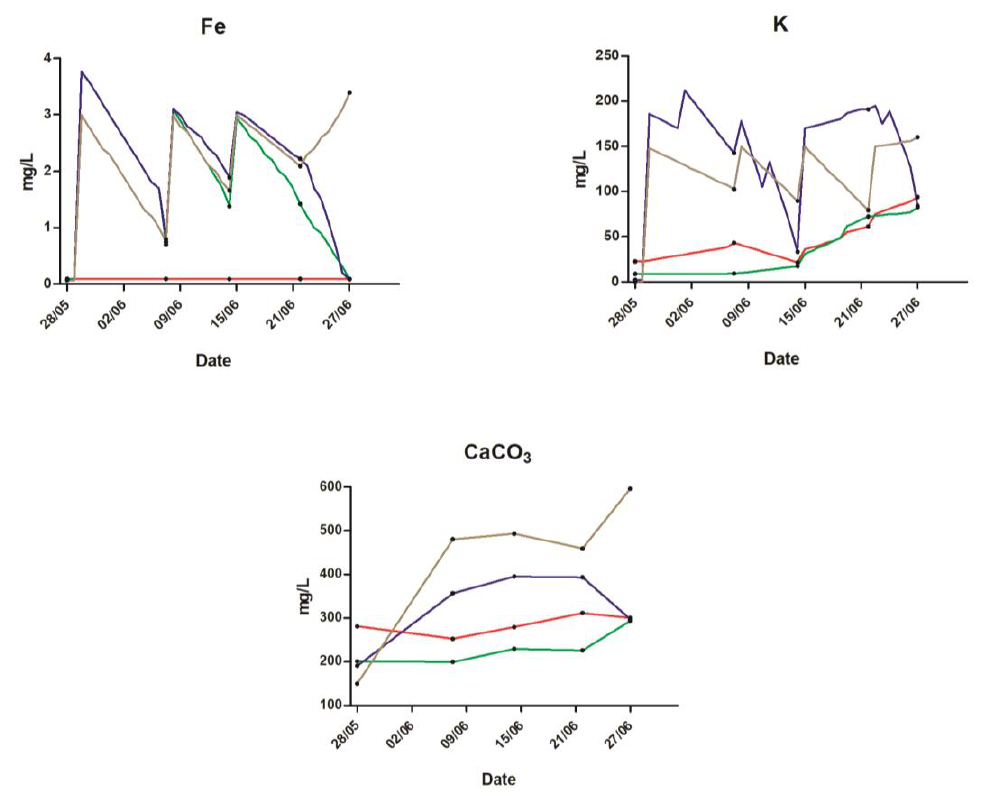
Figure 2. Concentrations of NO 3 -N, PO 4 -P, Ca, Mg, Fe, K, and CaCO 3 (water hardness) in systems A (red), B (green), C (blue), and D (brown). Starting measurements show the baseline fish water quality before starting the experiments. Symbols (dots) represent measured values; based on these, fertilizer supplements were calculated in order to achieve the target values. The most probable progressions of concentrations were calculated and depicted with lines. The graph depicting water hardness reports only measured values, since there were no target values.